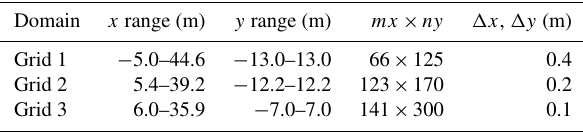
Table 1. Grid information for the solitary wave